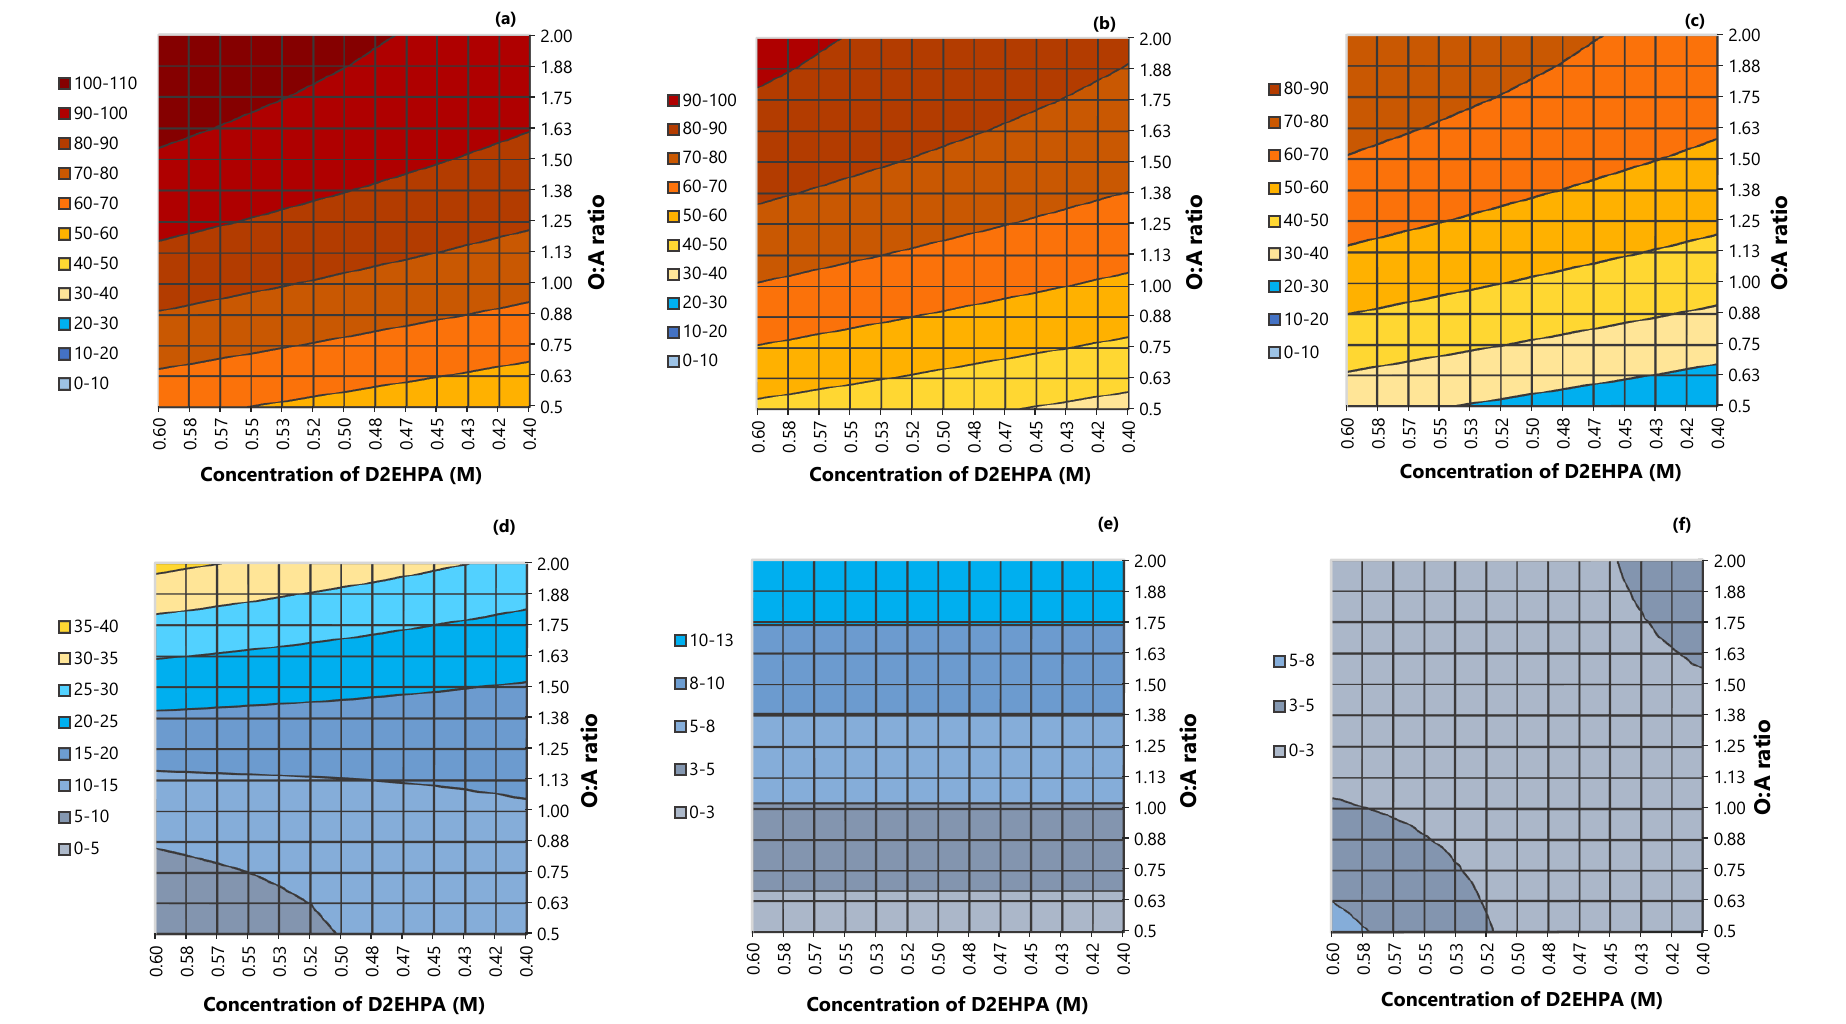
Figure 7. Contour plots representing the ( a – c ) extraction of manganese and the ( d – f ) coextraction of cobalt when the pH was set at 2.5 ( a , d ), at pH of 3.25 ( b , e ) and at pH 4 ( c , f ).